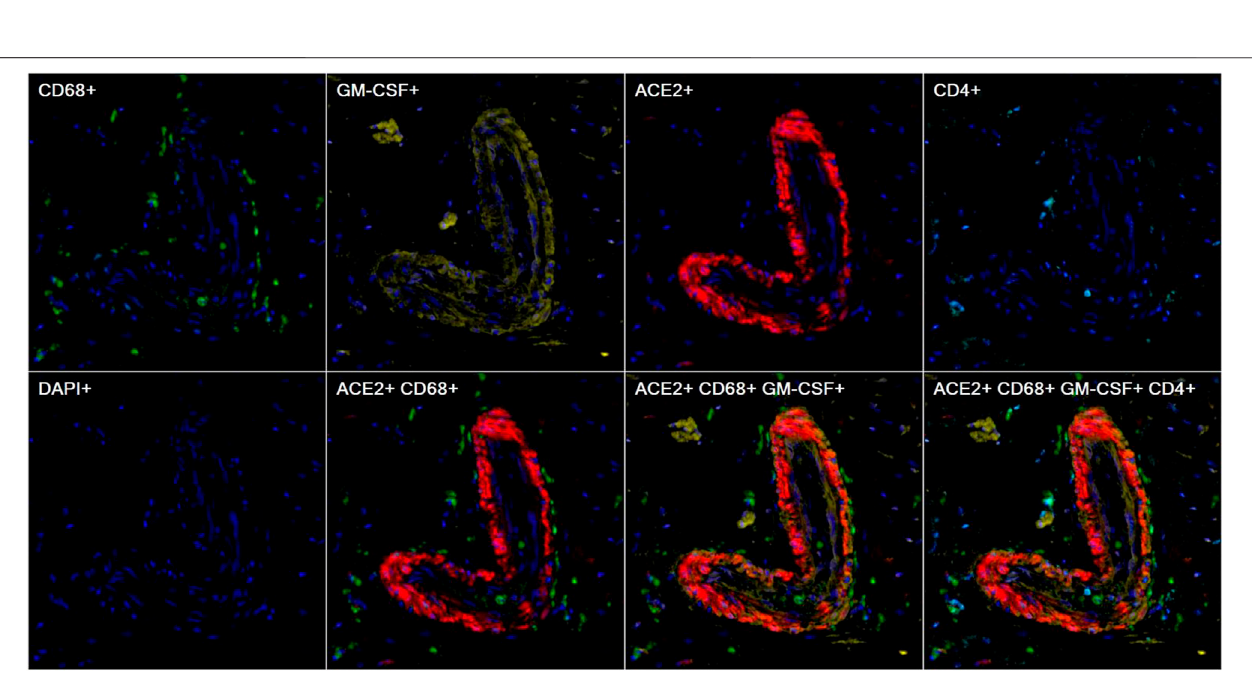
FIGURE9| Representativeimagesofhearttissuestainedusingmultipleximmunohistochemistry/immuno fl uorescence(mIHC/IF)[CD68(green),GM-CSF(yellow), ACE2 (red), CD4 (cyan), DAPI (blue)] (Magni fi cation, 200X).